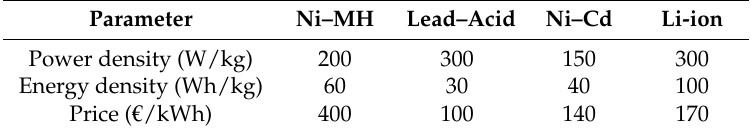
Table 6. Power density, energy density, and price for each battery technology [32–35].